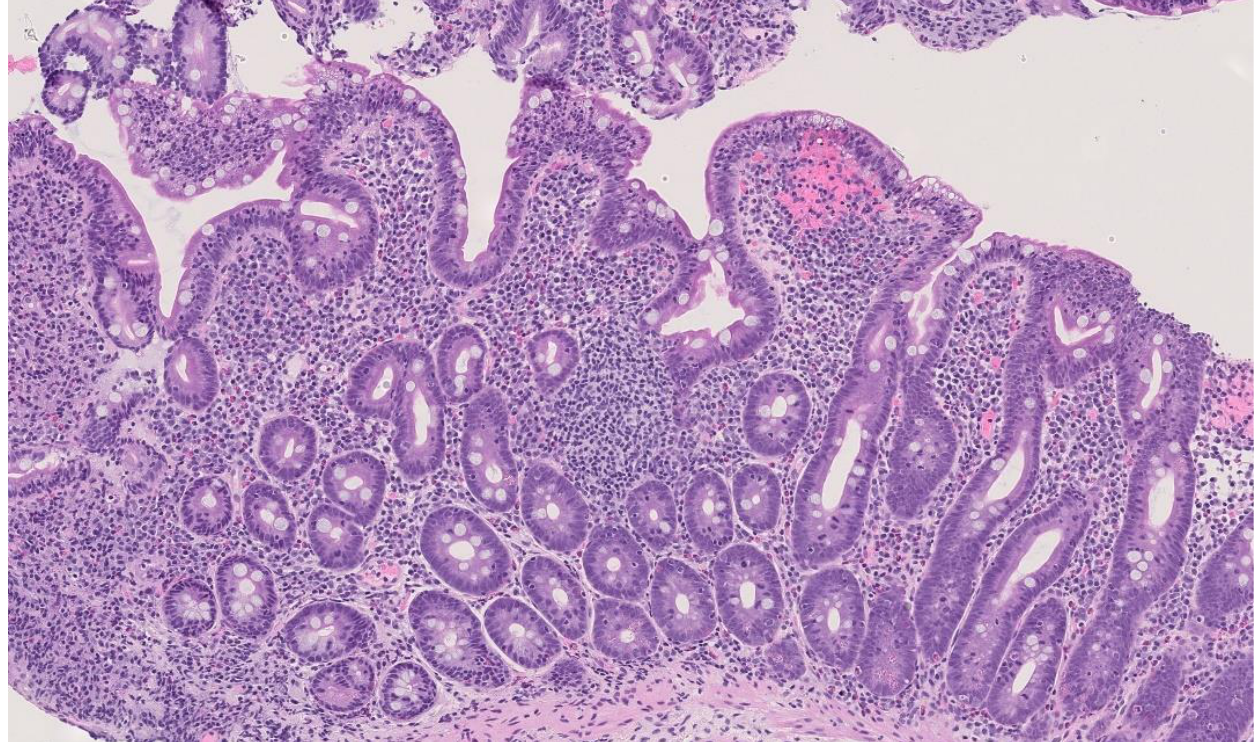
Figure 3. Duodenal mucosa showing partial villous atrophy and crypt hyperplasia with dense inflammatory infiltrate of the lamina propria and intraepithelial lymphocytes ILEs 42-44/100, H and E staining, original magnification 10×.